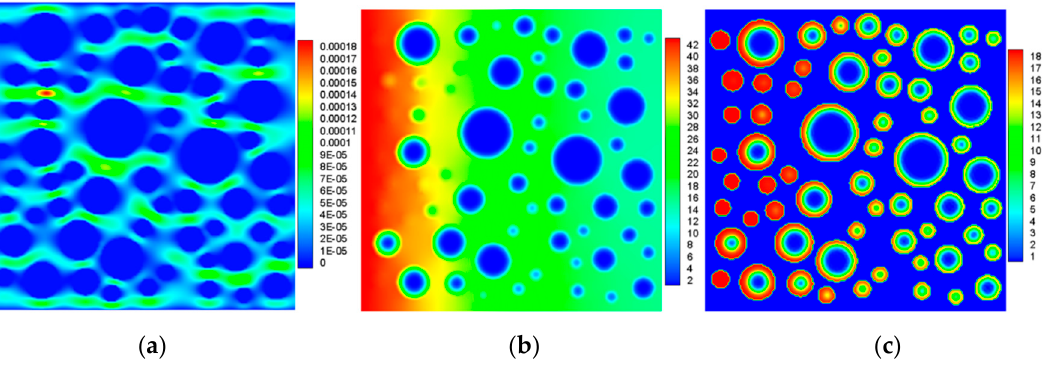
Figure 7. Simulation results at 500,000 steps. ( a ) The fluid velocity distribution, ( b ) the gas concentration distribution, and ( c ) the gas adsorption amount.